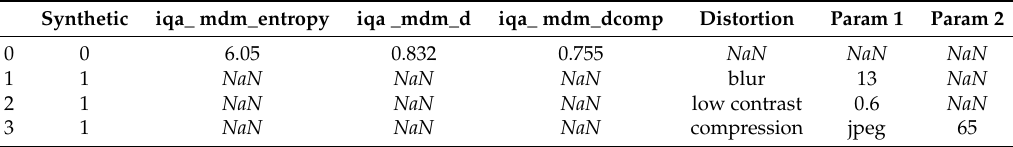
Table 4. Additional header/column fields for database augmentation, includes image quality metrics and distortion parameters. Row-0 shows the column values for a non-synthetic image, and Row-1 to Row-3 for distorted synthetic